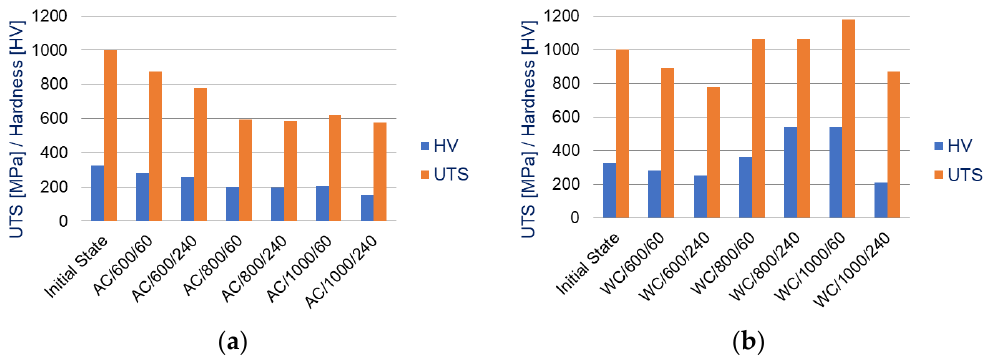
Figure 3. Diagram of dependencies between bolt steel hardness and bolt residual tensile strength on heating time for samples: ( a ) naturally air-cooled; ( b ) shock water-cooled.